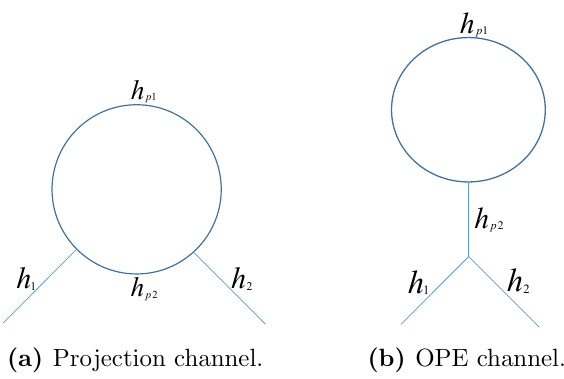
Figure 6 . Two di(cid:11)erent channels for two point function conformal blocks on the torus, with either a projection inserted between the operators, or the OPE taken between